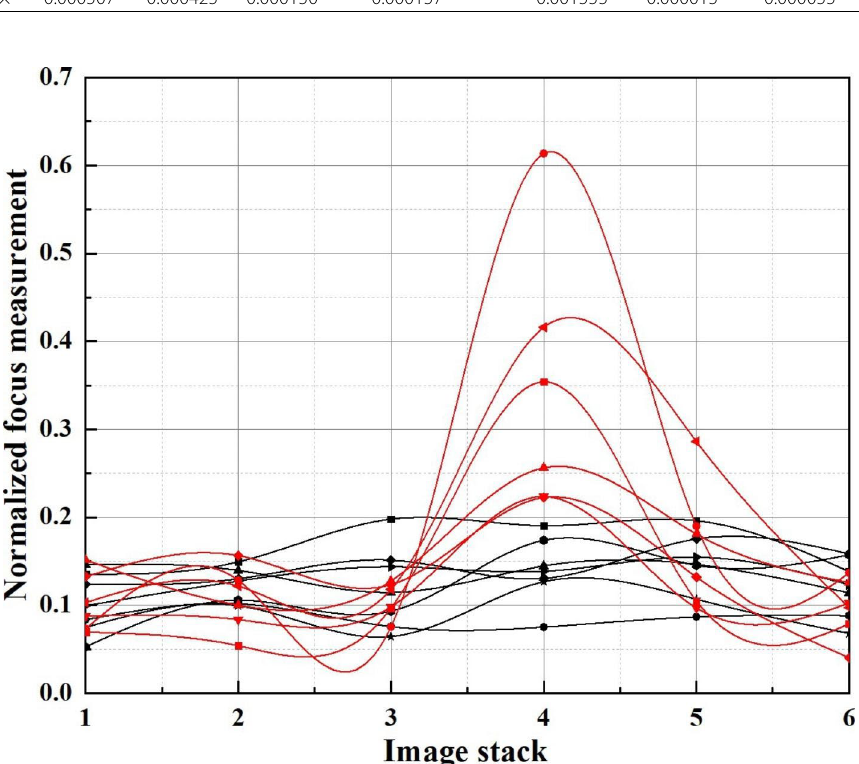
Fig. 12 Family of curves satisfying and dissatisfying Gaussian